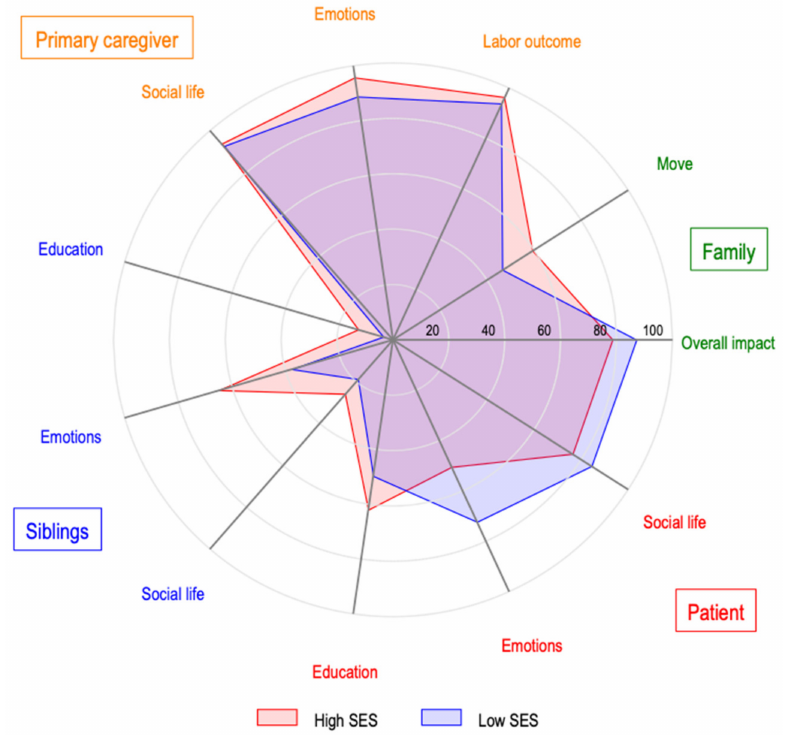
Figure 4. Relationship between the negative impact of the disease on the patients, siblings, primary caregiver, and